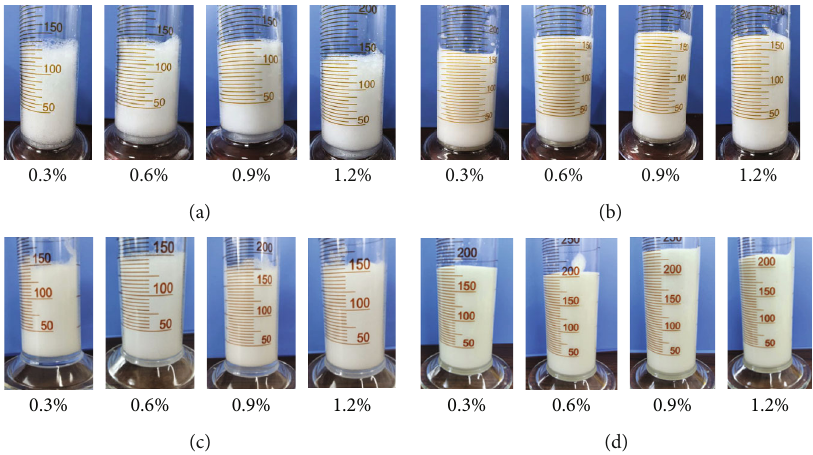
Figure 6: (a) Foaming situation of di ff erent mass concentrations of BPMO in kerosene. (d) Foaming situation of di ff erent mass concentrations of BPMO in diesel. (c) Foaming situation of di ff erent mass concentrations of DSFA in kerosene. (d) Foaming situation of di ff erent mass concentrations of DSFA in diesel.